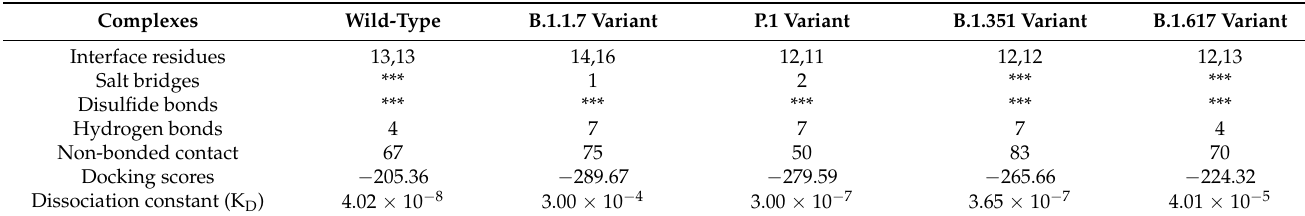
Table 1. Bonding pattern, docking scores, and dissociation constant of each complex are